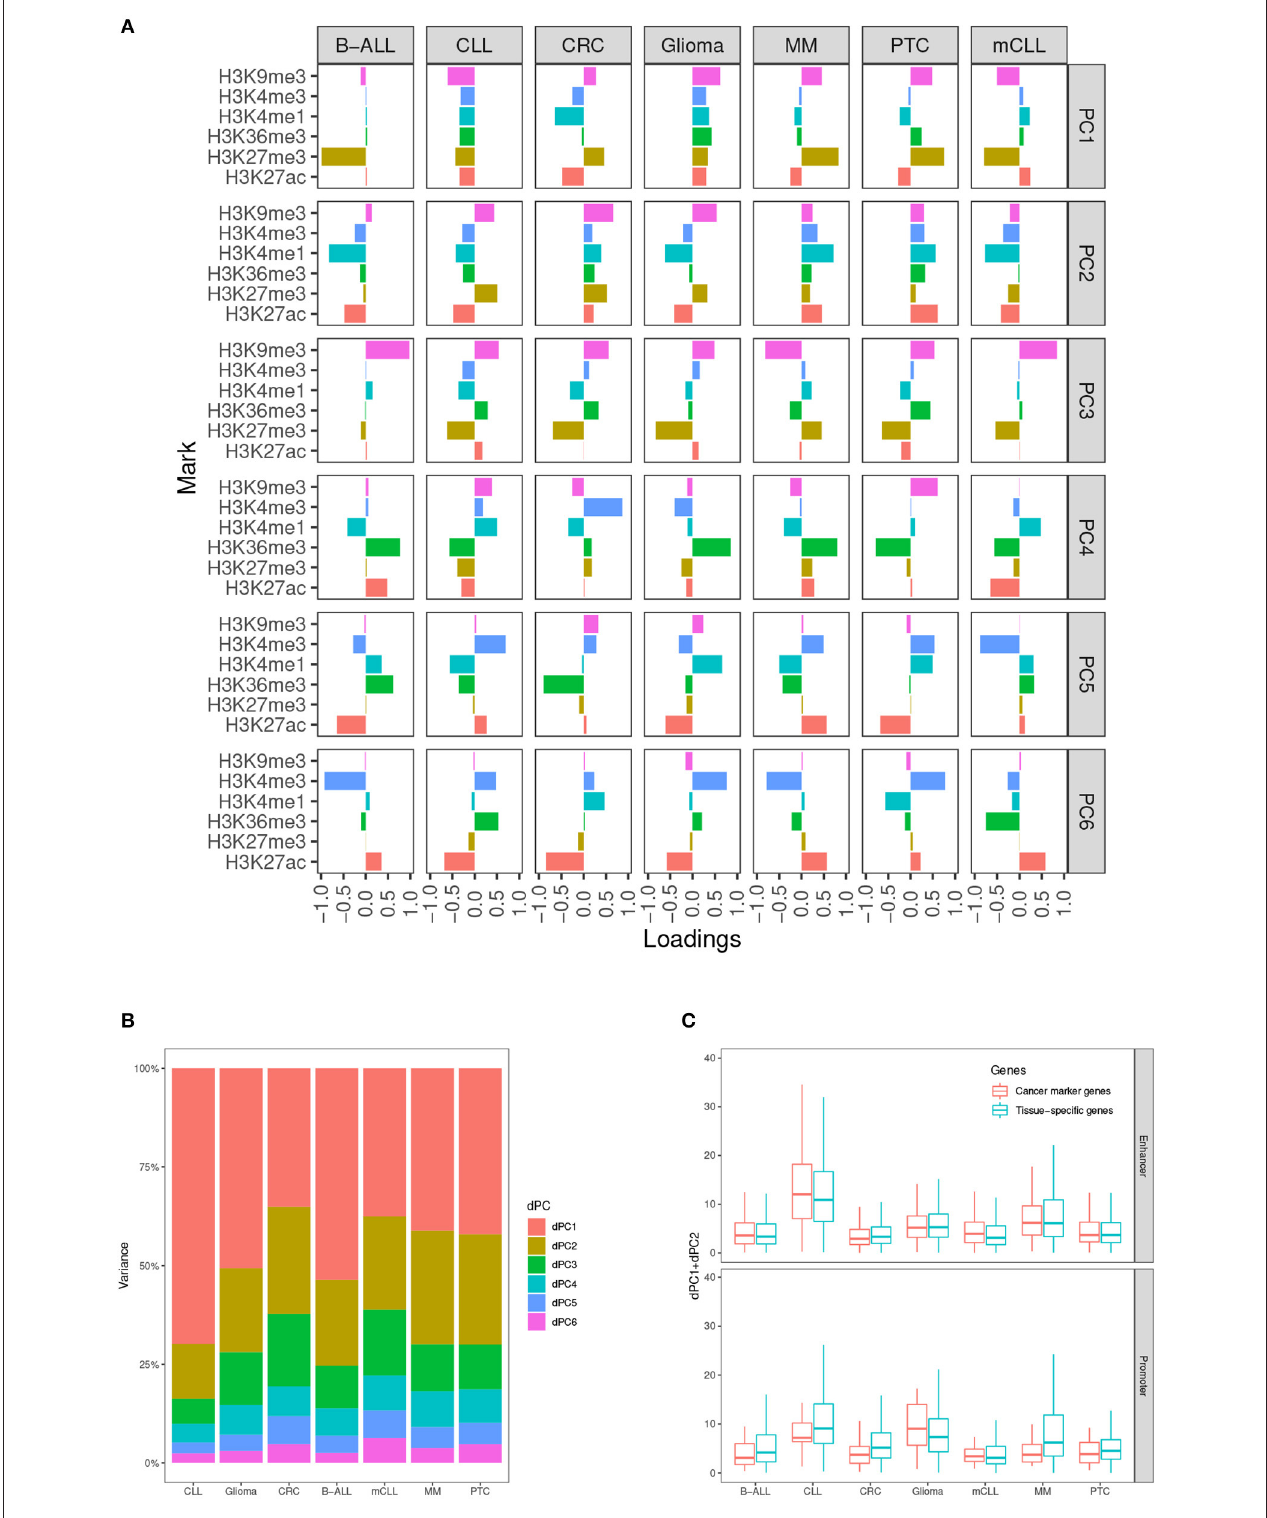
FIGURE 2 | Differential principal components. (A) Contributions of the six histone marks to each differential principal component (dPC). (B) Variances accounted for each dPC in the seven test cases. (C) Values of dPC1+dPC2 in the seven test cases, comparing cancer marker genes (CMGs) with TSGs, both for enhancers (top), and promoters